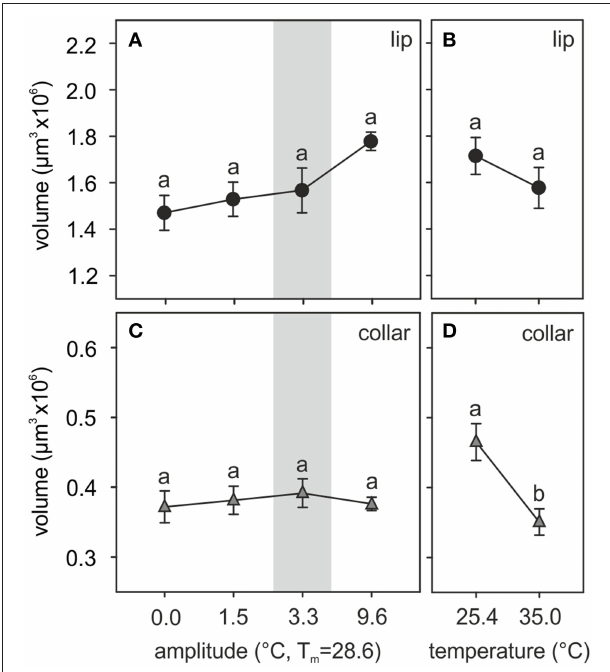
FIGURE 3 | Temperature effects on the adult MB calyx volume. (A,B) Volume of the olfactory lip and (C,D) the visual collar input regions of the MB calyces of ants reared at (A,C) different amplitudes of fluctuating temperature but the same mean temperature or (B,D) different constant temperature regimes. Gray area shows the temperature regime selected by nurses for brood translocation. Symbols represent the mean value of each group and lines the S.E. Different letters indicate significant differences among treatments with different amplitudes or between those with different constant temperatures. Lip and collar: N 0 = 13 , N 1.5 = 9 , N 3.3 = 12 , N 9.6 = 10 , N 25.4 = 14 , N 35 = 12